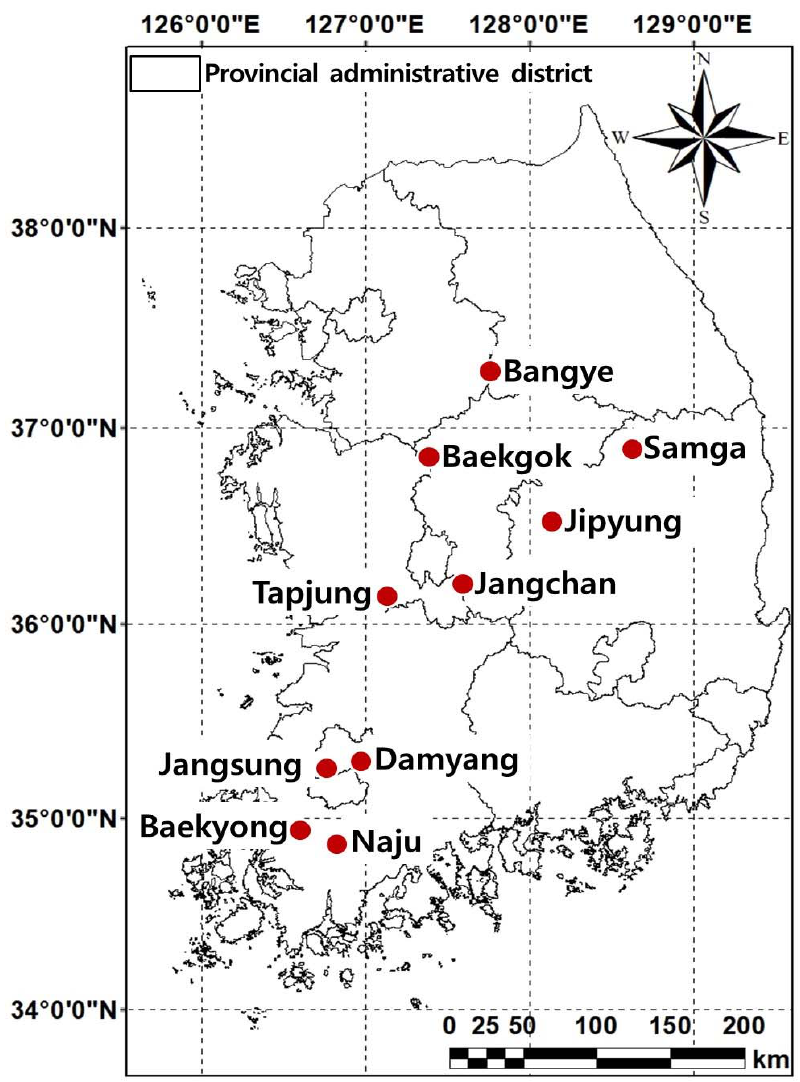
Figure 2. Reservoirs selected for assessment of flood vulnerability in South Korea.